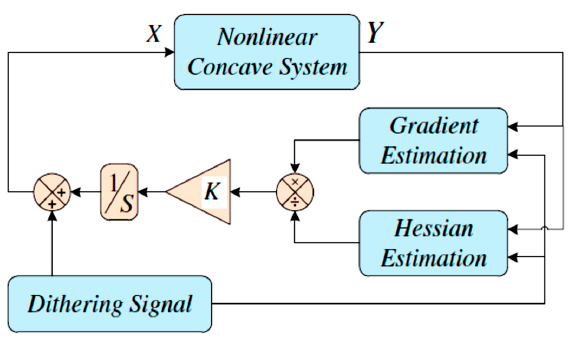
Figure 2. Classical ESC scheme [31] (Reprint with permission from [31]; 2013 Elsevier Ltd).